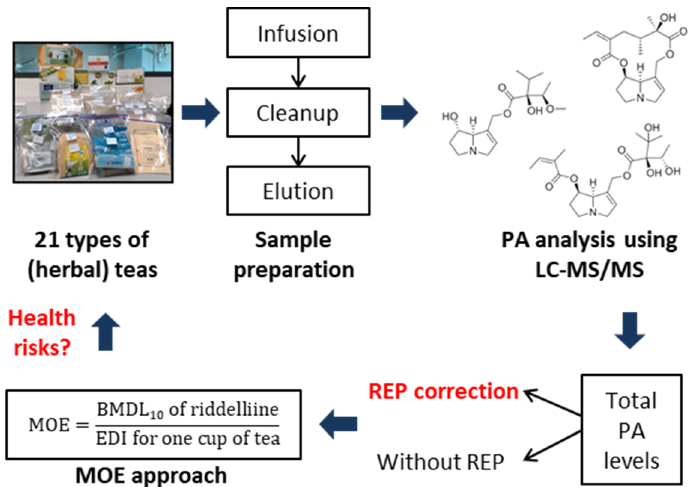
Scheme 1. Graphical workflow for the whole analytical procedure in this study.